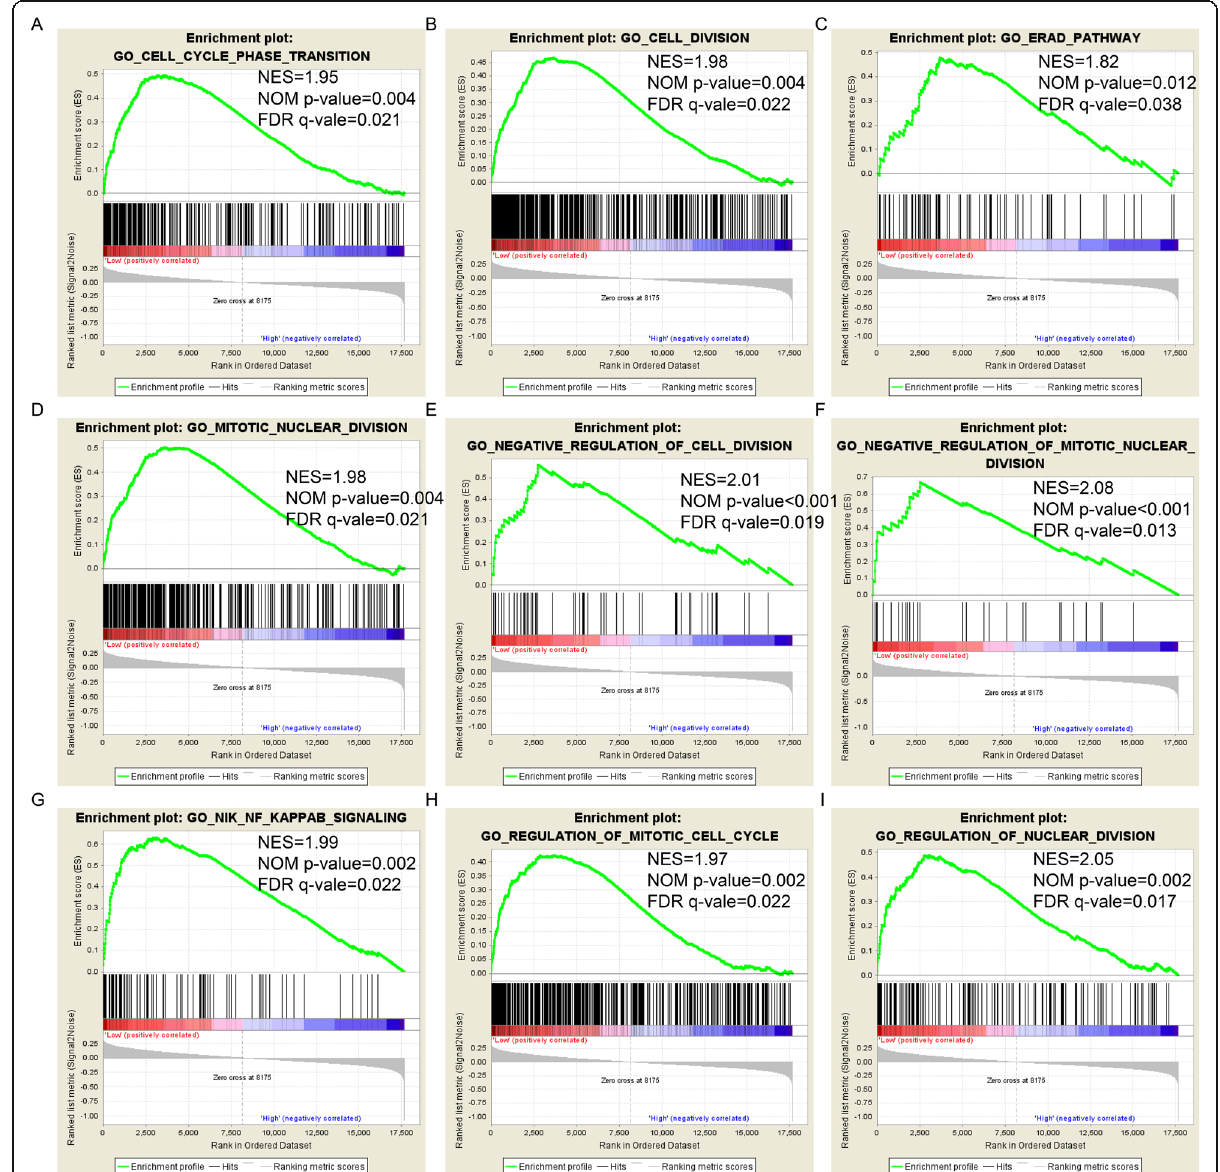
Fig. 7 GO enrichment results by GSEA for GSTM2 . ( a ) Cell cycle phase transition; ( b ) Cell division; ( c ) Erad pathway; ( d ) Mitotic nuclear division; ( e ) Negative regulation of cell division; ( f ) Negative regulation of mitotic nuclear division; ( g ) NIK/NF kappa B signaling; ( h ) Regulation of mitotic cell cycle; ( i ) Regulation of nuclear